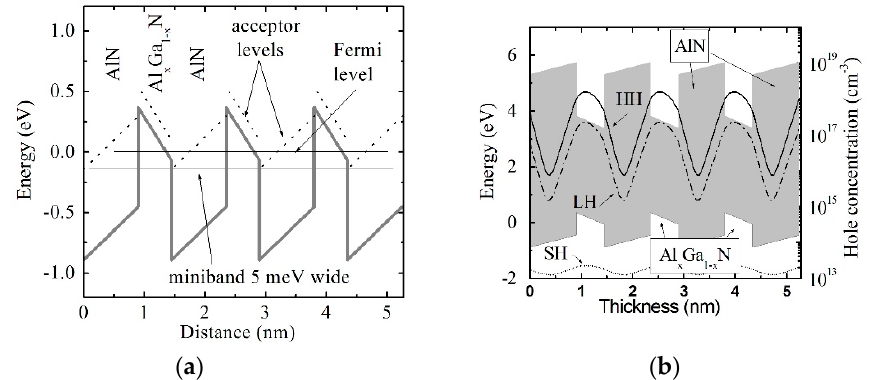
Figure 7. Valence band layout in AlN/Al 0.03 Ga 0.97 N SPSL, computed for room temperature ( a ) and band diagram and heavy (HH), light (LH), and split-off (SH) hole concentrations in this sample ( b ). The acceptor level positions were estimated by neglecting the effect of the hole confinement in the quantum wells.